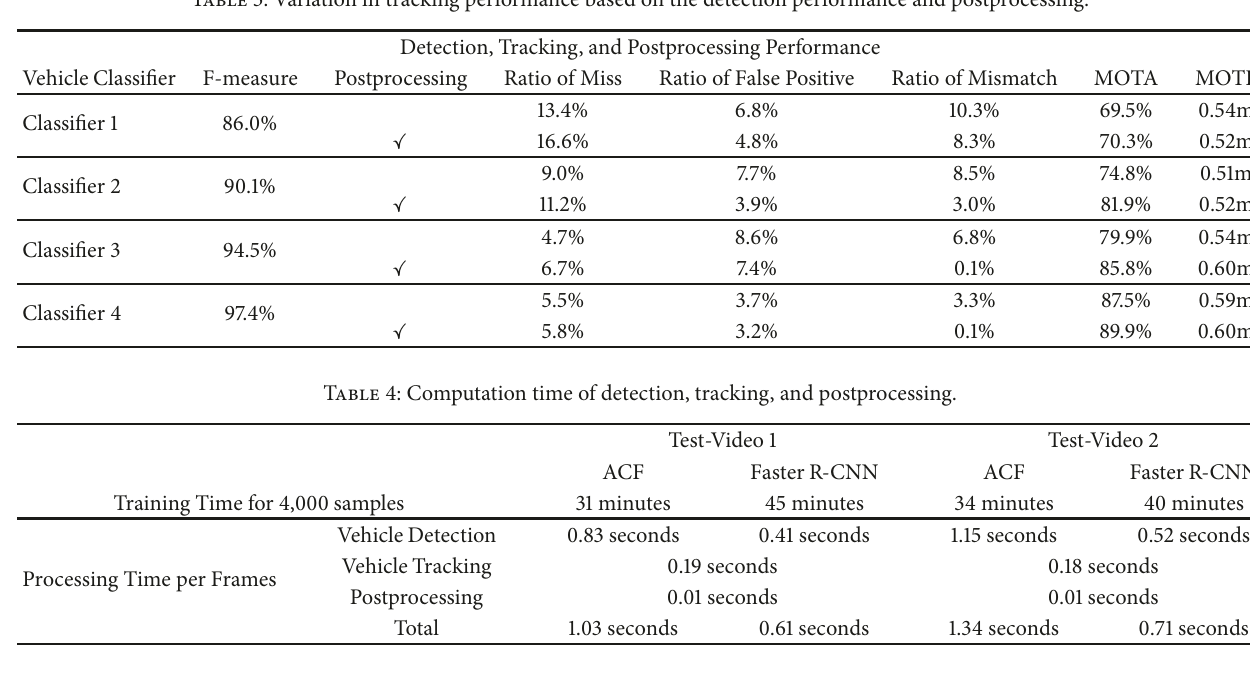
Table 5: Performance evaluation for obtaining aggregated traffic